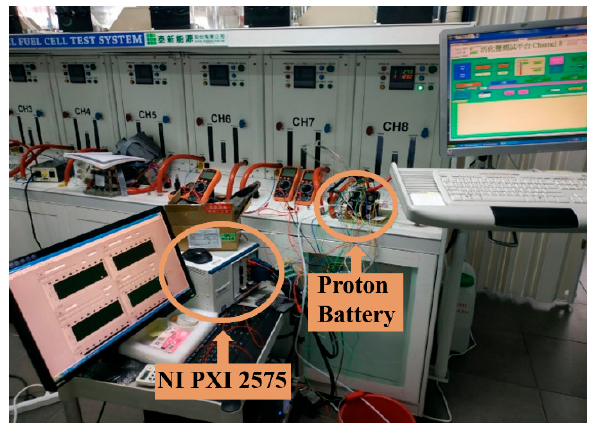
Figure 9. Discharge